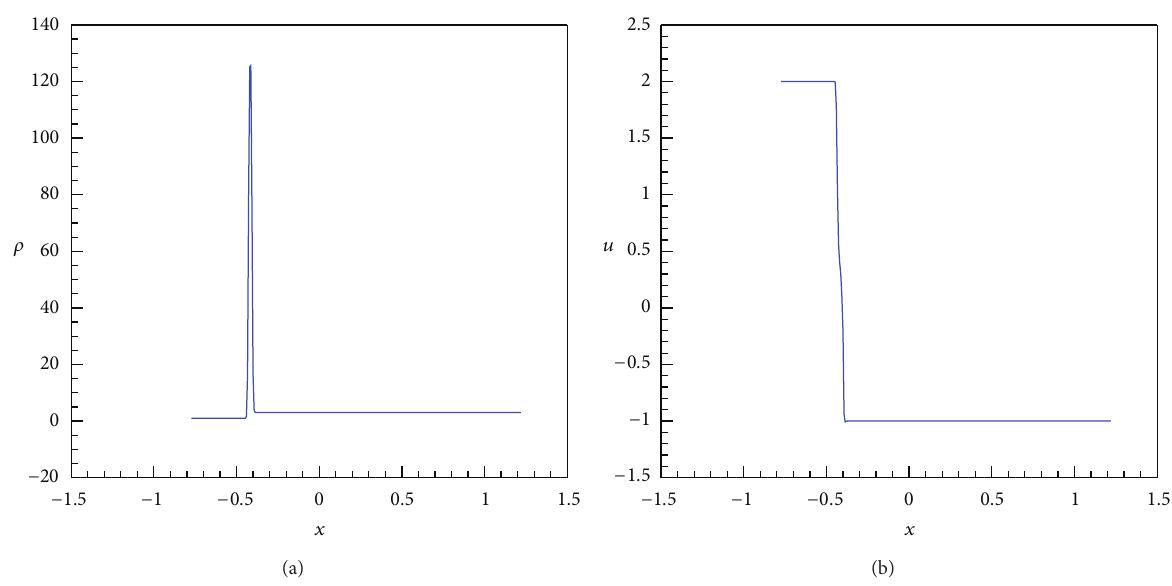
Figure 5: Numerical results for the case 𝑢 − ≥ 𝑢 + + (1/𝜌 + ) at 𝑡 = 0.5